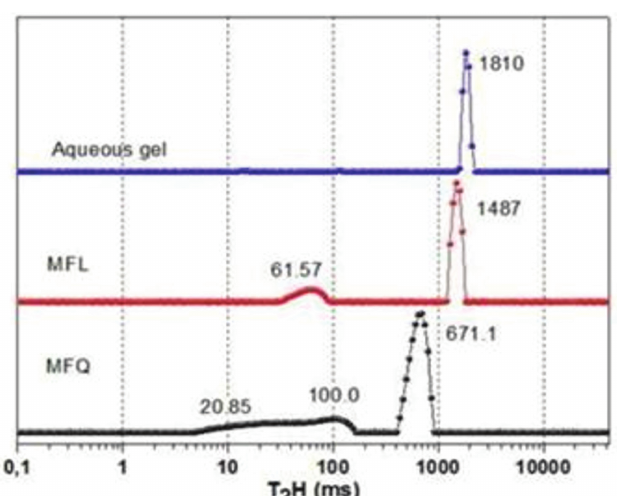
H D domain distribution curves. Abbreviation: FIGURE 2 - T 2 MFQ - formulation containing octyl- p -methoxycinnamate (OMC), benzophenone-3 (BP-3), ethylhexylmethoxycrylene (EHMCR) and keratin; MFL - formulation containing OMC, BP-3 and